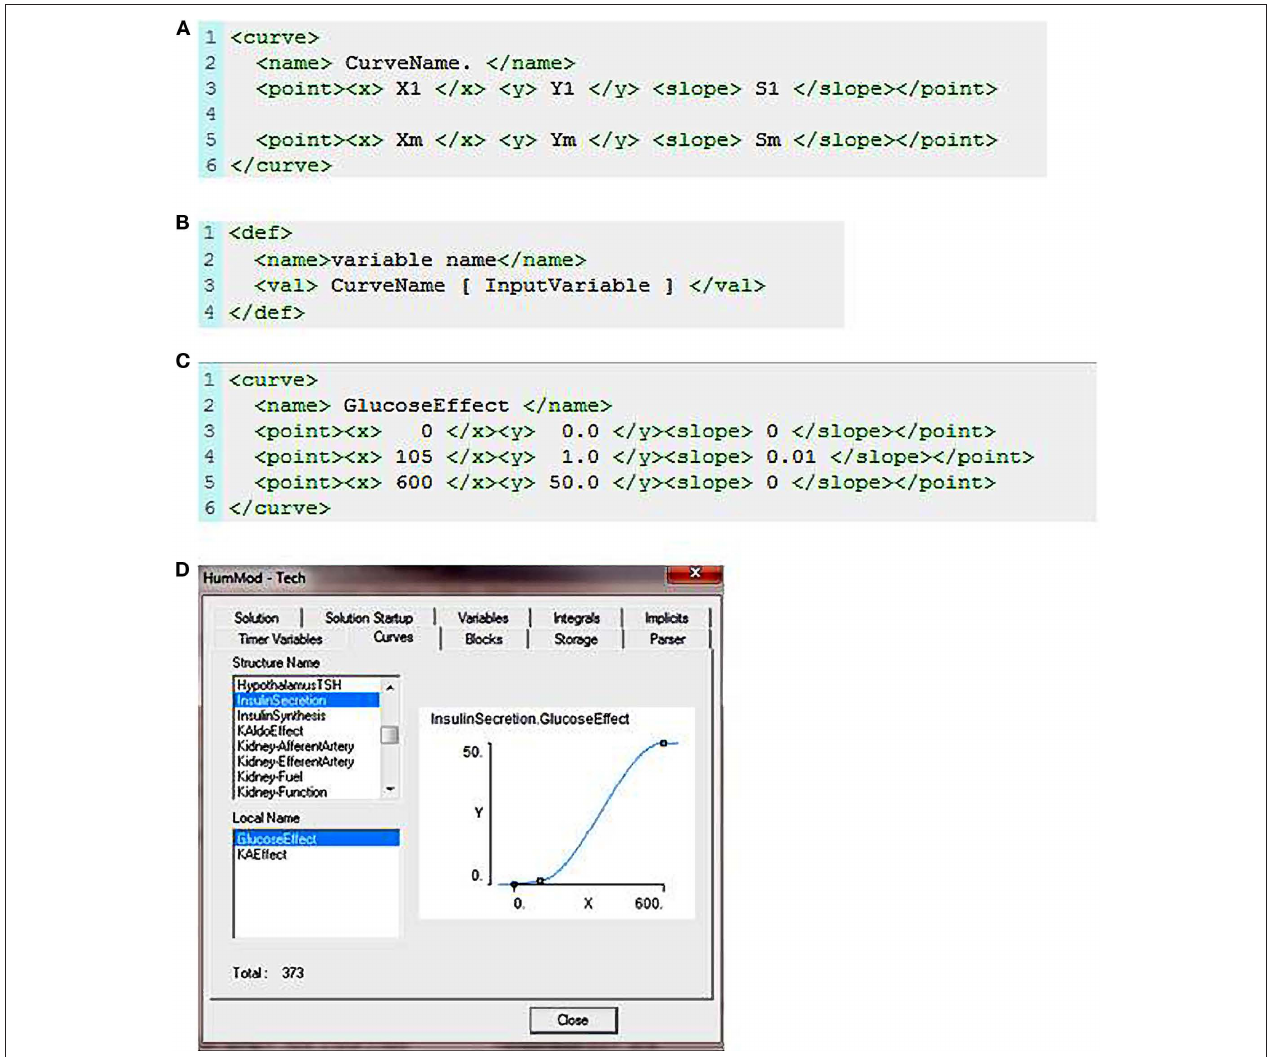
FigurE 1 | (A) The XML code used to describe a curve function. X m is an X value, Y m is the associated Y value, and S m is the slope of the curve at the X m, Y m data point. (B) This demonstrates how the curve function is called in the XML code. “Variable name” is the output value returned following evaluation of the curve function at a given input value. (C) Describes the relationship between blood glucose and insulin release. (D) Shows the sigmoid fit based on the X , Y , and slope data presented in